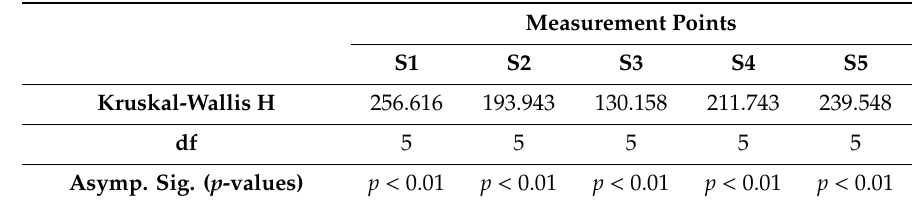
Table 2. Kruskal-Wallis test statistics for spatial distribution.